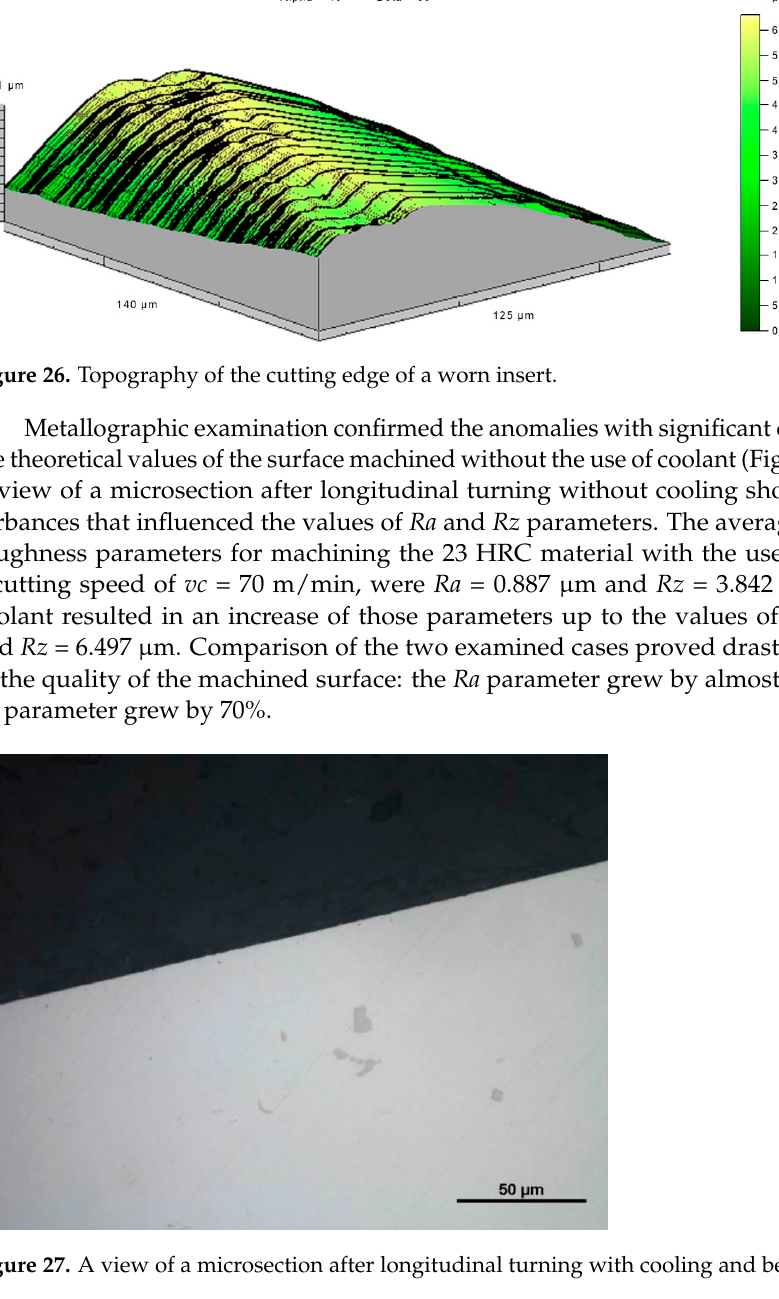
Figure 25. Topography of the cutting edge of a new insert.